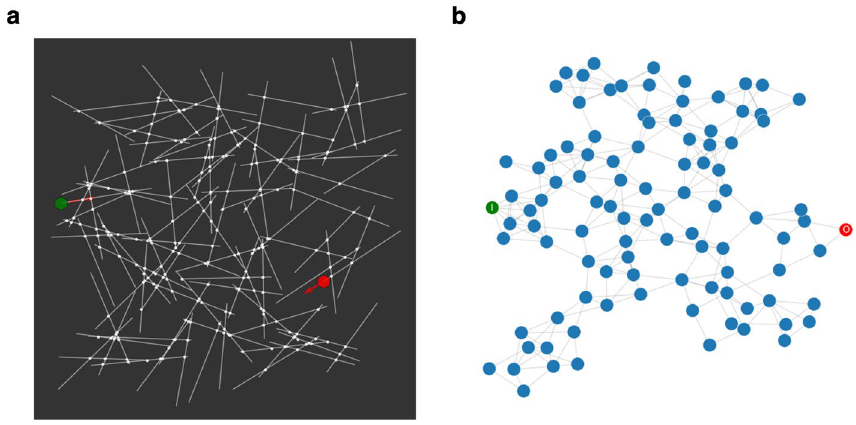
Figure 7. ( a ) Simulated NWN with 100 nanowires and 261 junctions. ( b ) Graphical representation of the NWN in ( a ). Green denotes input nanowire contact electrode-node and red represents drain